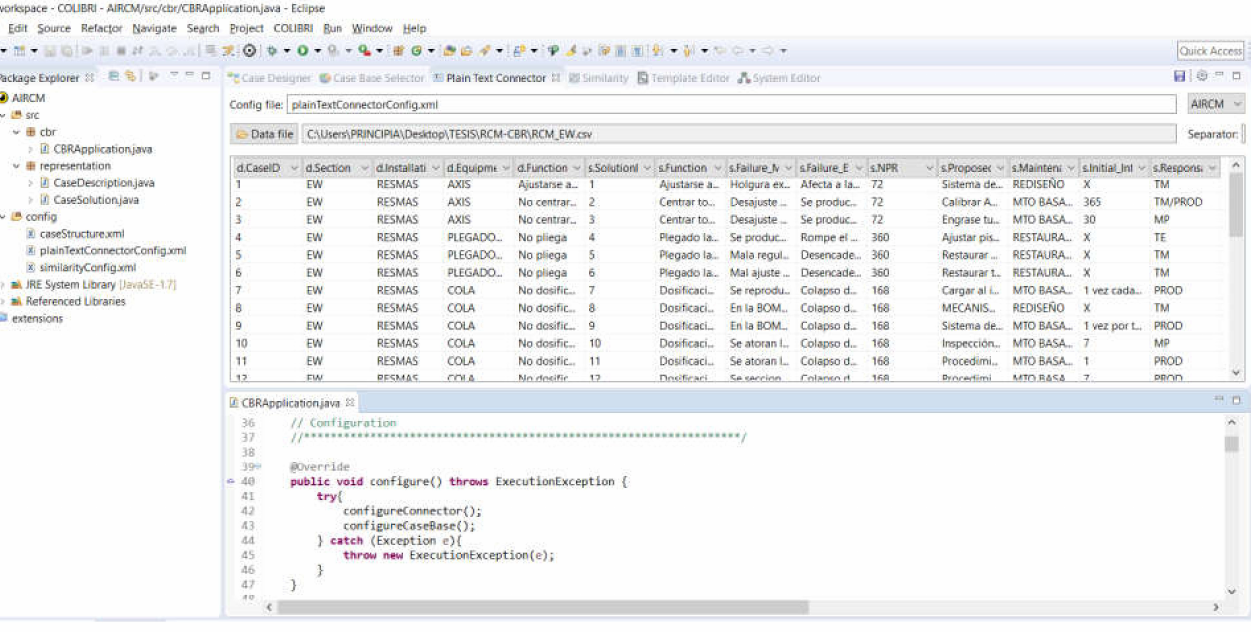
Figure 5. Java development environment in the eclipse IDE from the jCOLIBRI